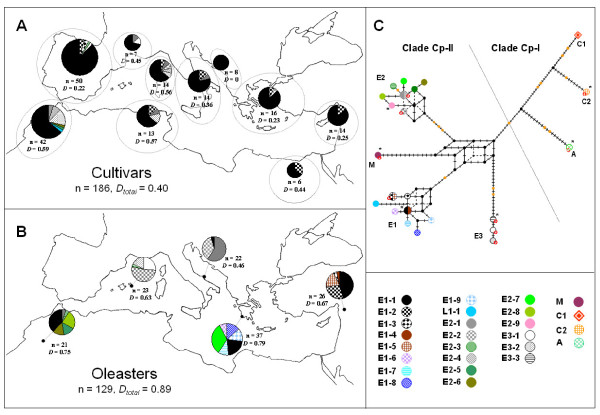
Plastid DNA variation in the Mediterranean olive trees. A. Distribution of the cpDNA haplotypes in cultivated olive trees (see also Additional file 5 for the list of cultivars and the corresponding cpDNA haplotype). B. Distribution of haplotypes in the five studied oleaster populations. For both cultivated and wild gene pools, the number of accessions (n) and the discriminating power (D, Dtotal) of cpDNA variation is given for each region or population and on the global sample. C. Reduced-median network [54] of cpDNA haplotypes. The traits on branches represent each individual change. Indels are specifically distinguished by bigger orange traits. Each haplotype is represented by a symbol with a definite colour. The name of each cpDNA clade or lineage is given according to Besnard et al. [15] (see also Figure 2). The missing, intermediate nodes are indicated by small black points. CAPS-XapI and CAPS-EcoRI were not considered in this analysis. For this reason, three pairs of haplotypes (i.e., E1-1/E1-4, E1-2/E1-5 and E2-1/E2-4) are not distinguished in the network. In addition, the nine haplotypes not restricted with XapI are indicated with a red circle. * haplotypes for which a complete genome was released in the present study.